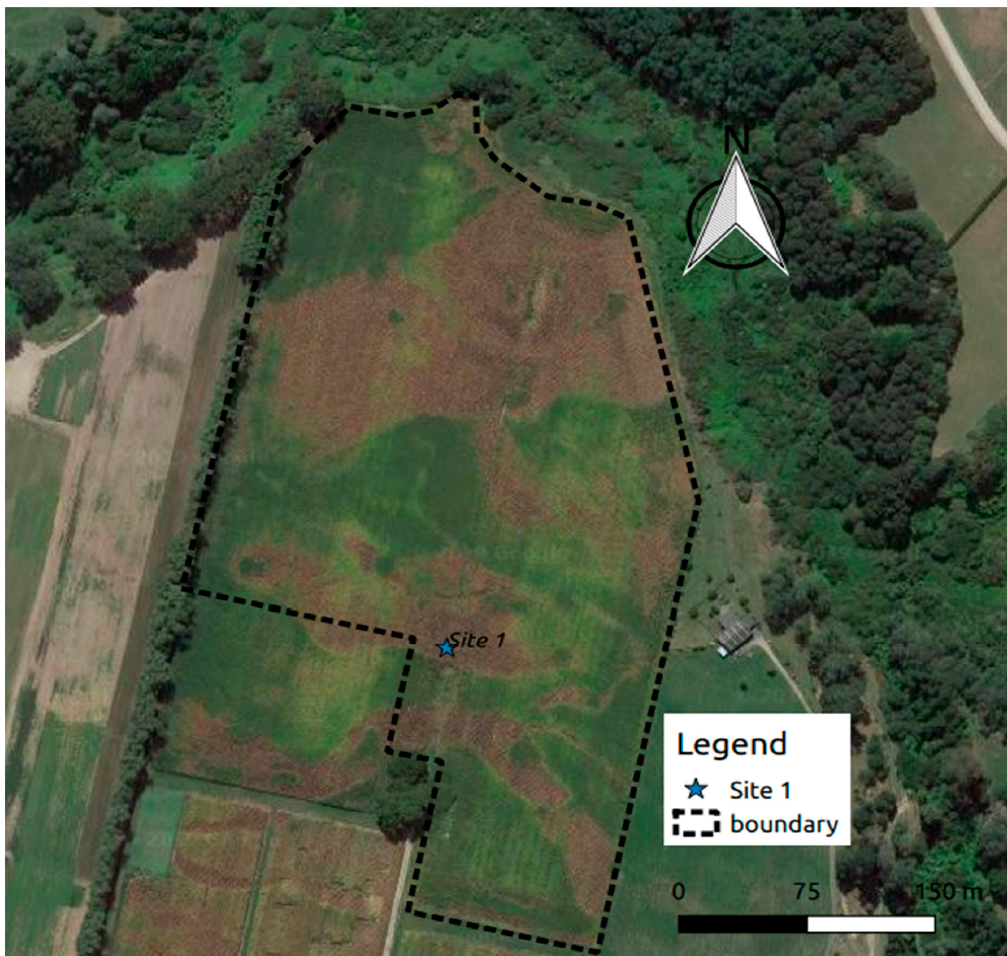
Figure 3. Google Earth image–true colour composite (site 1).